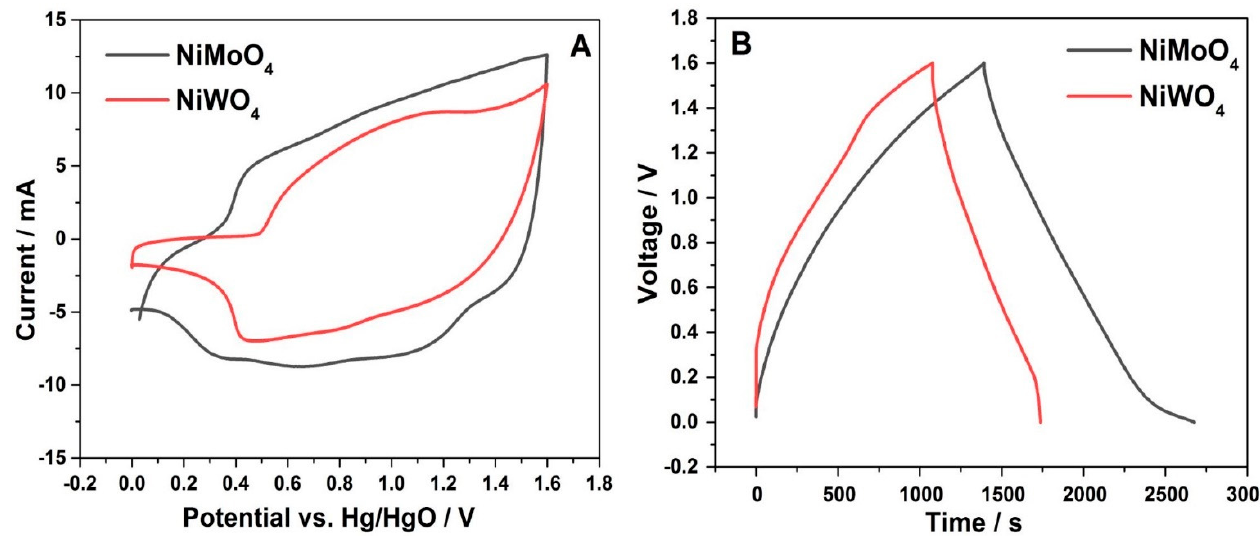
Figure 11. Comparative ( A ) cyclic voltammetric curves at 5 mV s –1 , and ( B ) charge-discharge profiles at 3 mA cm –2 of NiMoO 4 and NiWO 4 asymmetric devices, respectively, in 2 M NaOH solution.